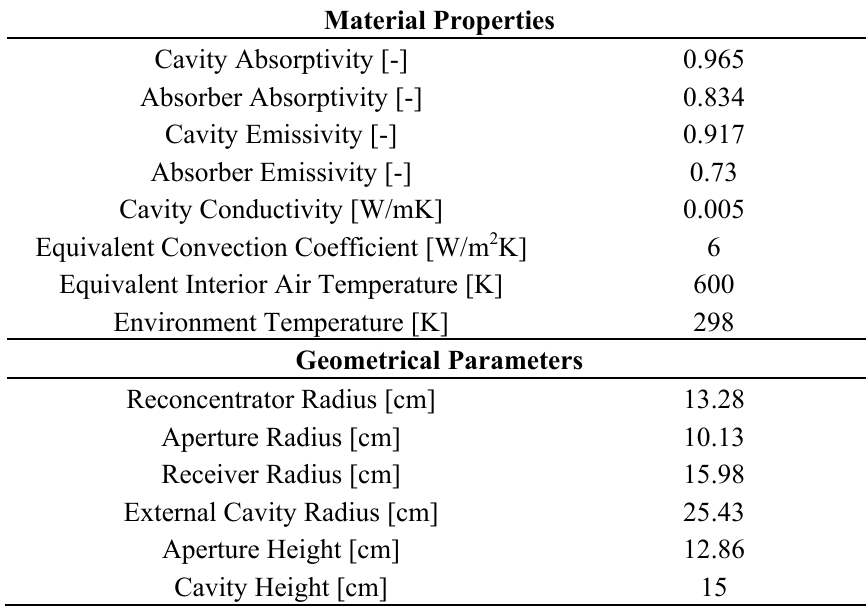
Figure 6. EES (Engineering Equation Solver) tool interface. Table 1. Material properties and geometrical parameters in